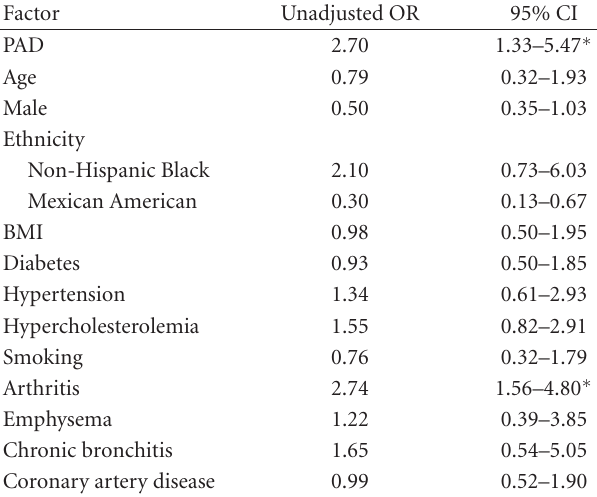
Table 2: Simple logistic regression analysis showing association of each variable and functional limitation in patients with CHF.